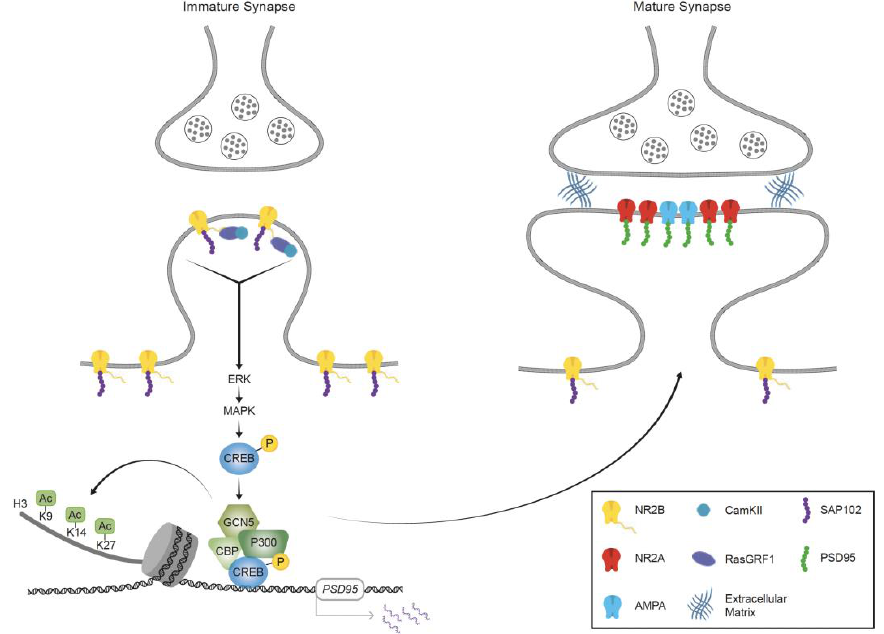
Figure 2. Proposed model of how the NMDAR-ERK-CREB-signaling pathway leads to activation of the PRG PSD-95 through epigenetic mechanisms. In immature neurons, NR2B-NMDARs (important for neuronal plasticity) are enriched at the synapse via the interaction with the scaffold protein SAP102 (synapse-associated protein 102). Calcium influx through synaptic NR2B-NMDARs immediately activates CaMKII and RasGRF1 (coupled directly to the C-terminal tail of the NR2B subunit), which in turn induce the activation of ERK, MAPK and CREB (CREB-P). Activated CREB-P act as a transcription factor and recruits CBP, P300 and GCN5 to the PSD-95 gene promoter. Subsequently, these HATs promote the acetylation of K residues in the histone H3 tail (H3K9/14/27ac) to induce gene transcription (depicted under the PSD-95 gene). The produced PSD-95 proteins will be centrally inserted into the synapses and hold NR2A-NMDARs, displacing the previously synaptic SAP102- bound NR2B-rich receptors laterally to the extra-synaptic membrane. The synaptic NR2A-NMDARs are critical for neuronal refinement as well as for learning and